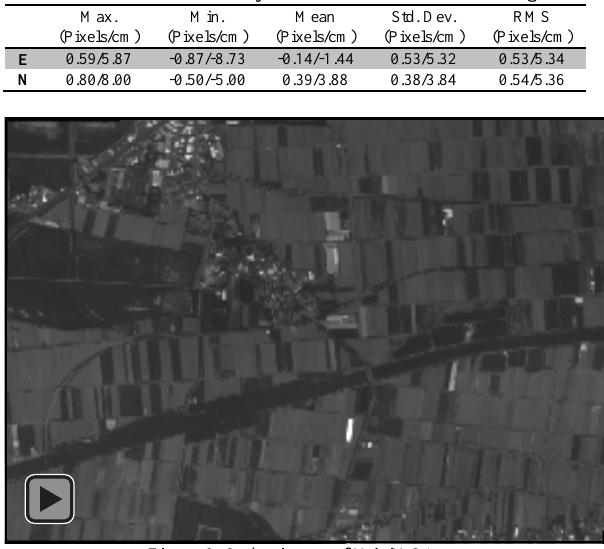
Figure 9. Ortho-image of MiniMCA.